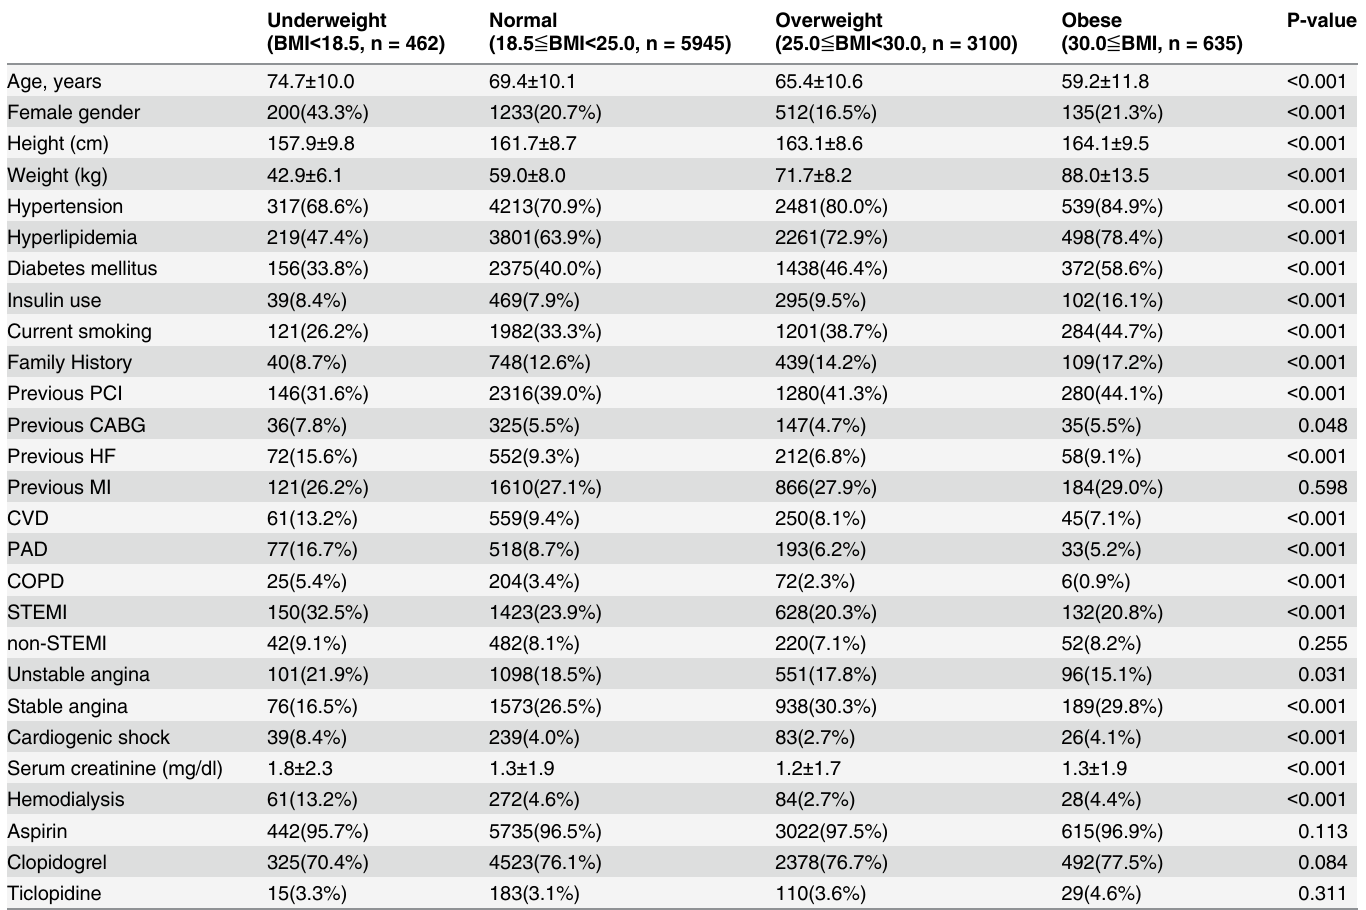
Table 1. Baseline Clinical